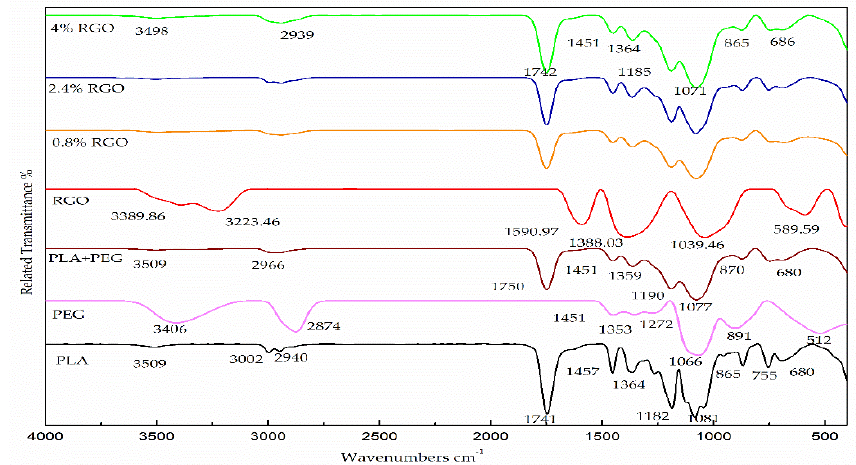
Figure 7. The Fourier transform infrared (FT-IR) bands of the pure PLA, pure PEG, PLA/PEG mixture, and the RGO/PLA/PEG nanocomposites at different percentages of filler.